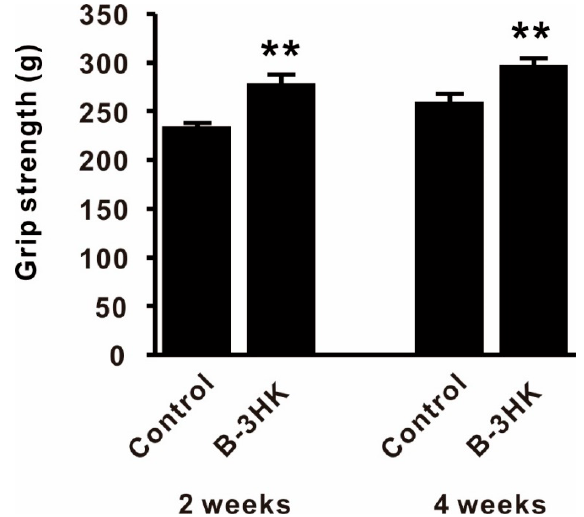
Figure 6. The effect of B-3 on whole-body grip strength in mice. Physical performance was analyzed by the grip strength test at 2 and 4 weeks ( n = 18). Differences with the control group were analyzed for significance using Student’s t -test (** p < 0.01). The data are expressed as the means and SEs.